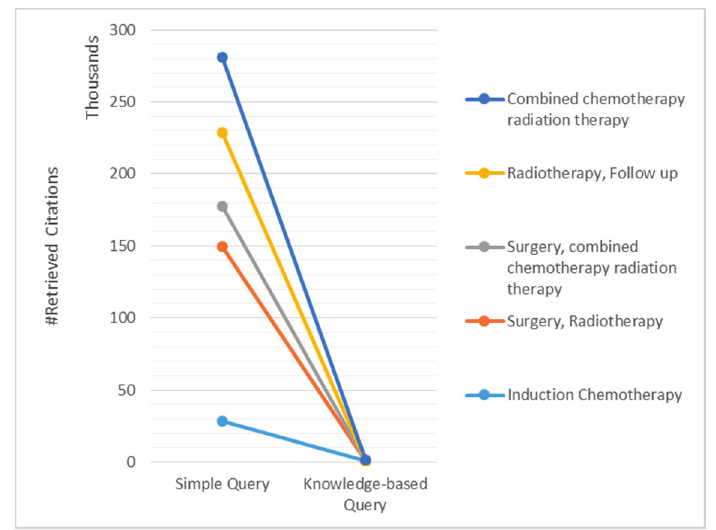
Figure 6. Retrieval set reduction with knowledge-based constructed query compared to simple query.